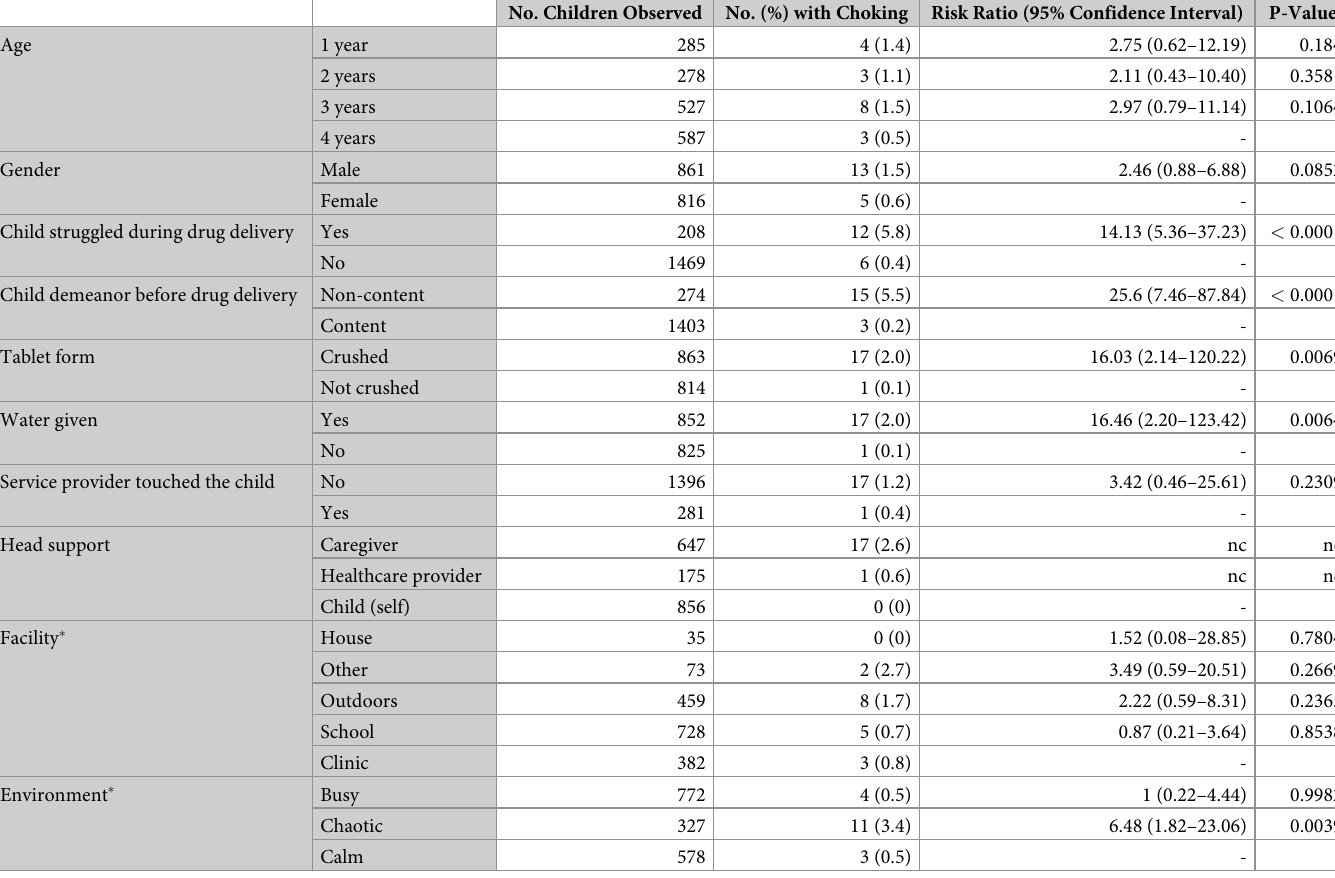
Table 5. Number and percentage of choking occurrences observed by variable, at sites in Haiti and India,